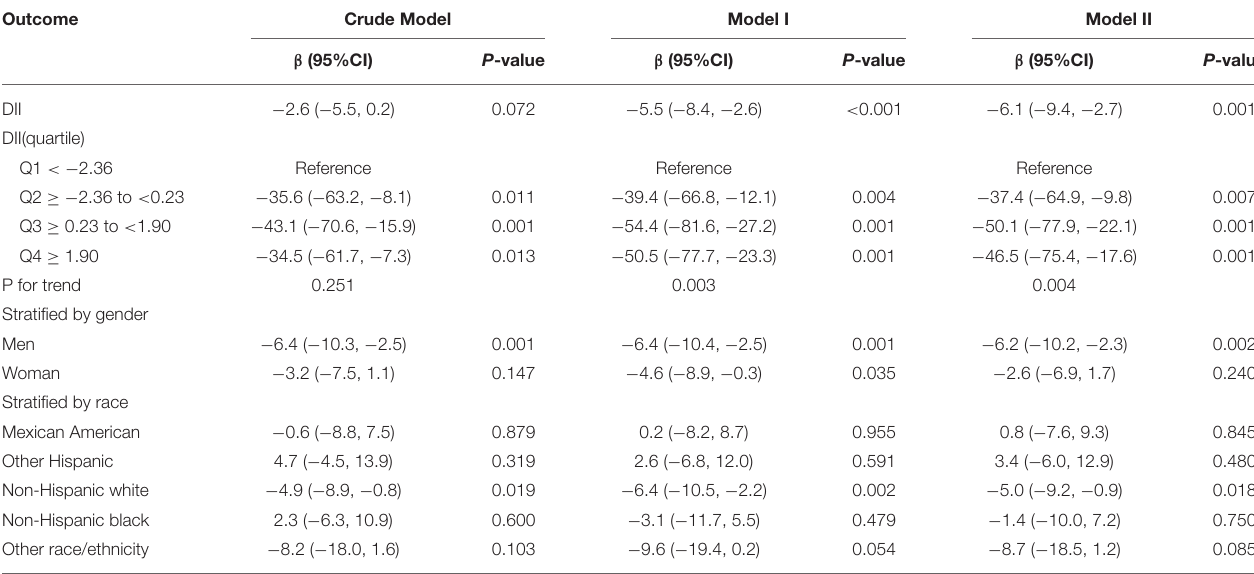
TABLE 3 | Relationship between Dietary Inflammatory Index (DII) and S-Klotho